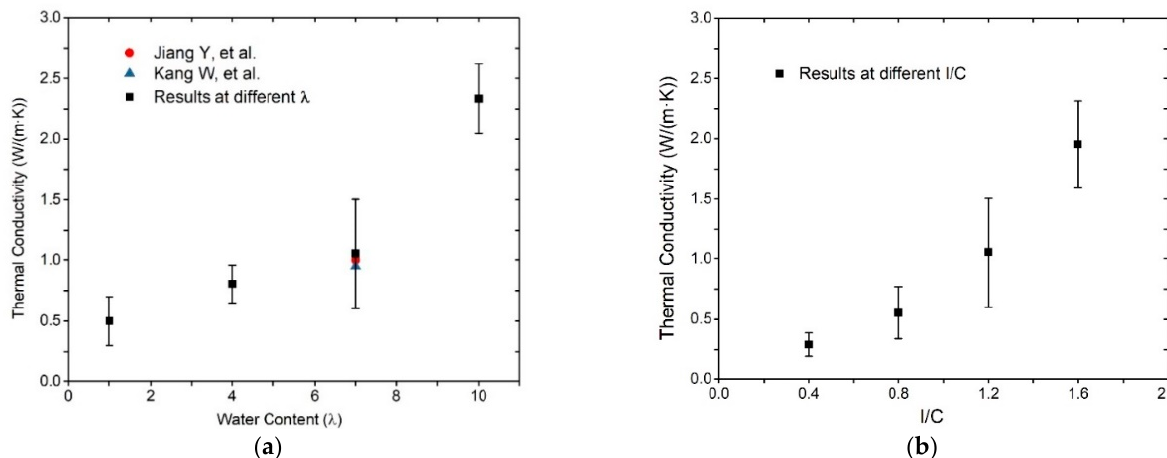
Figure 11. Thermal conductivity of CL with ( a ) different water contents and ( b ) different ionomer-to-carbon ratios.